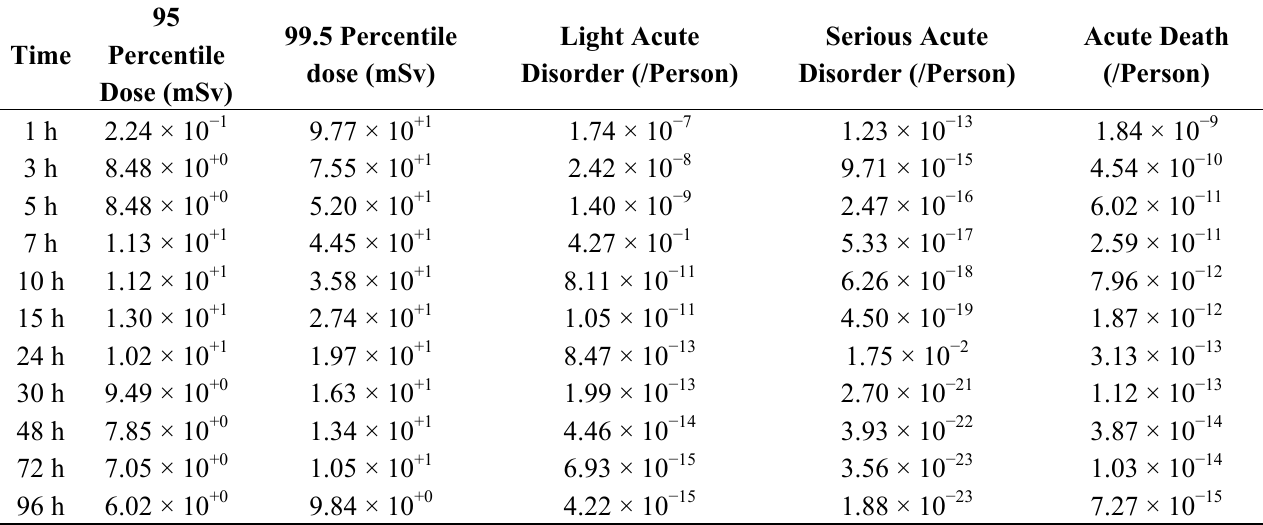
Table 3. Radiation dose and acute health impact by effluent duration